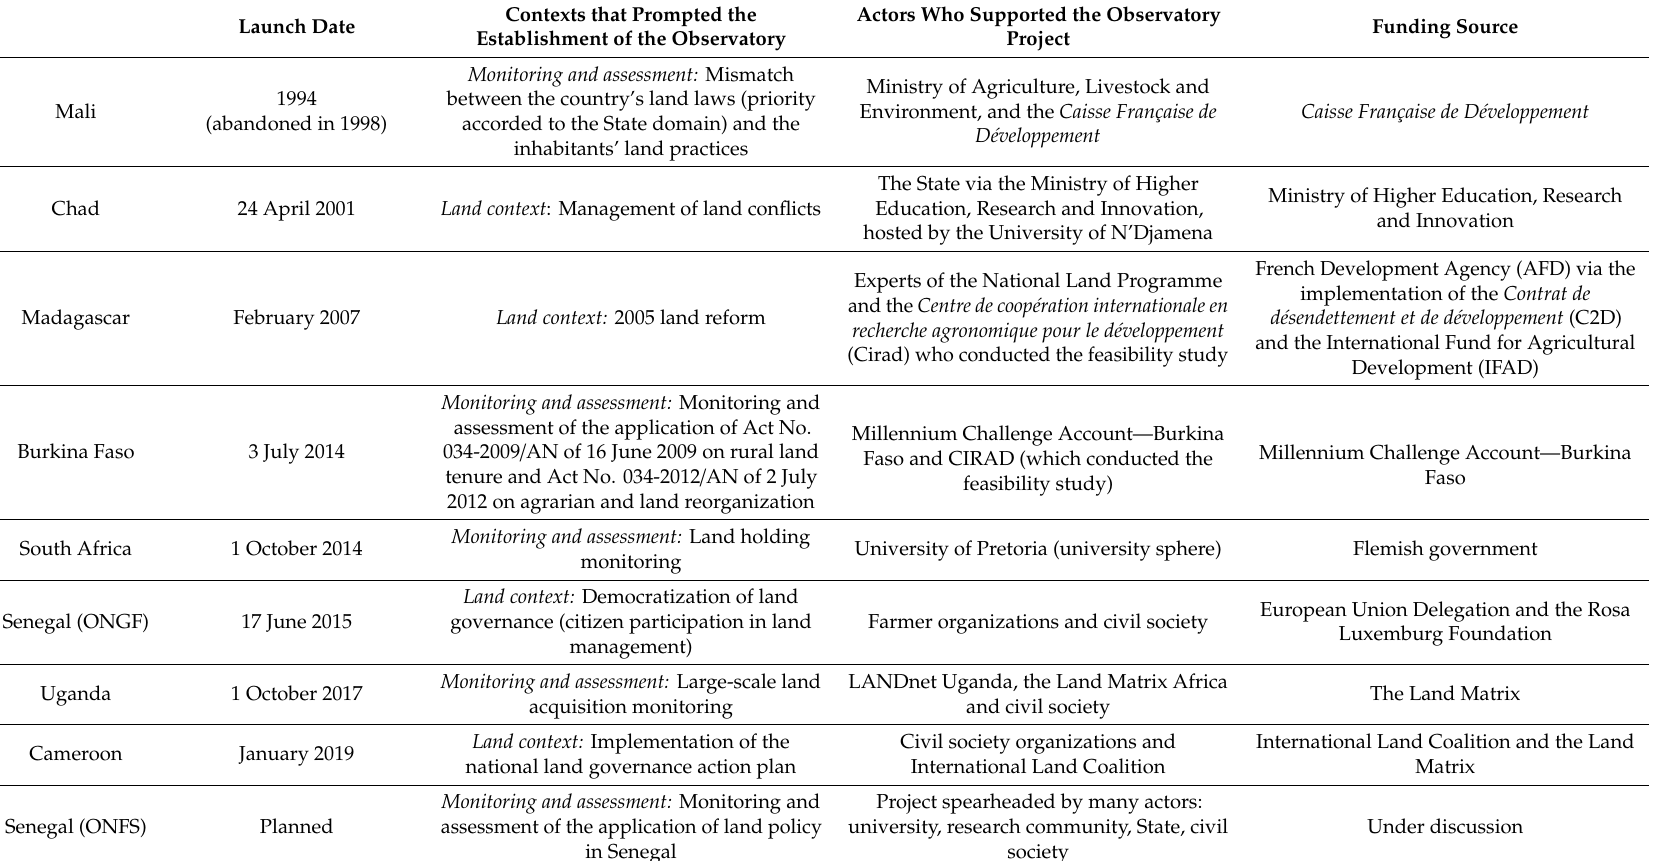
Basic information on nine land observatories based on certain core dimensions (complete table with all core dimensions can be found in Supplementary